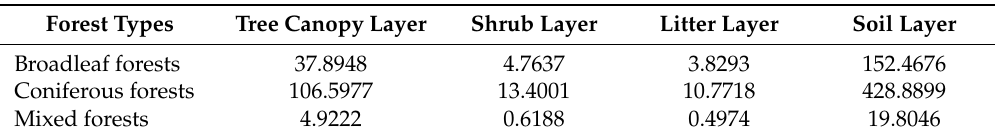
Table 3. Carbon density (t · hm − 2 ) of tree canopy layer, shrub layer, litter layer, and soil layer in different forest types in Hubei Province